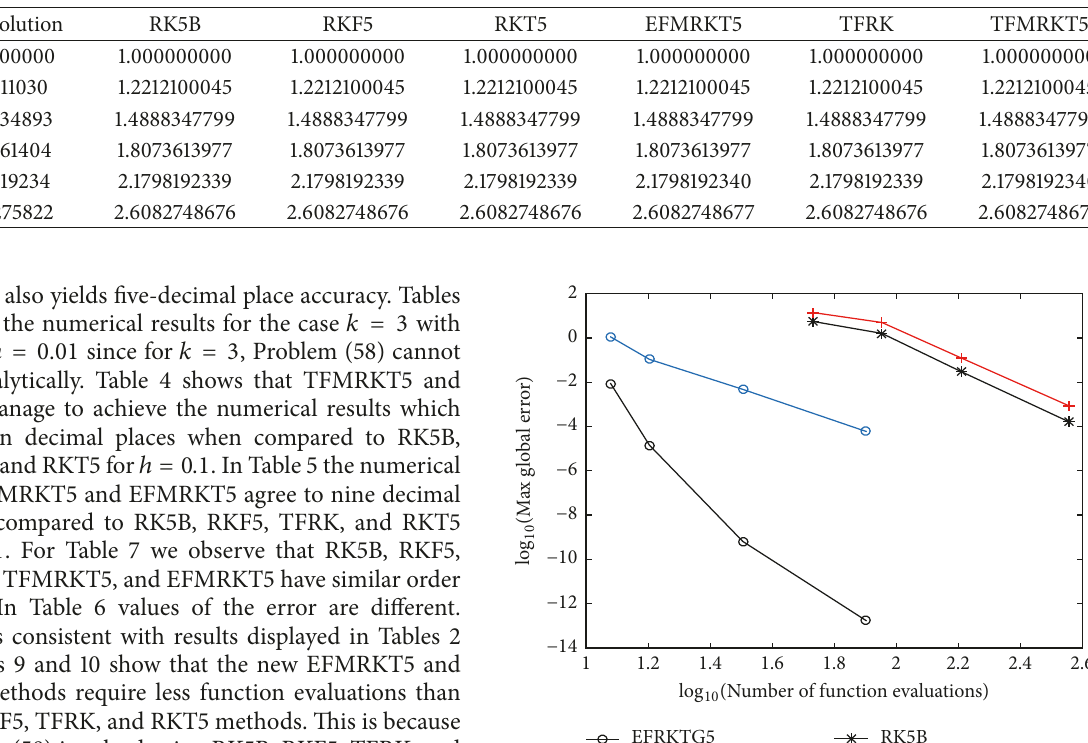
Table 3: Numerical results for problem in thin film flow (58) taking ℎ = 0.01 and 𝑘 = 2 .